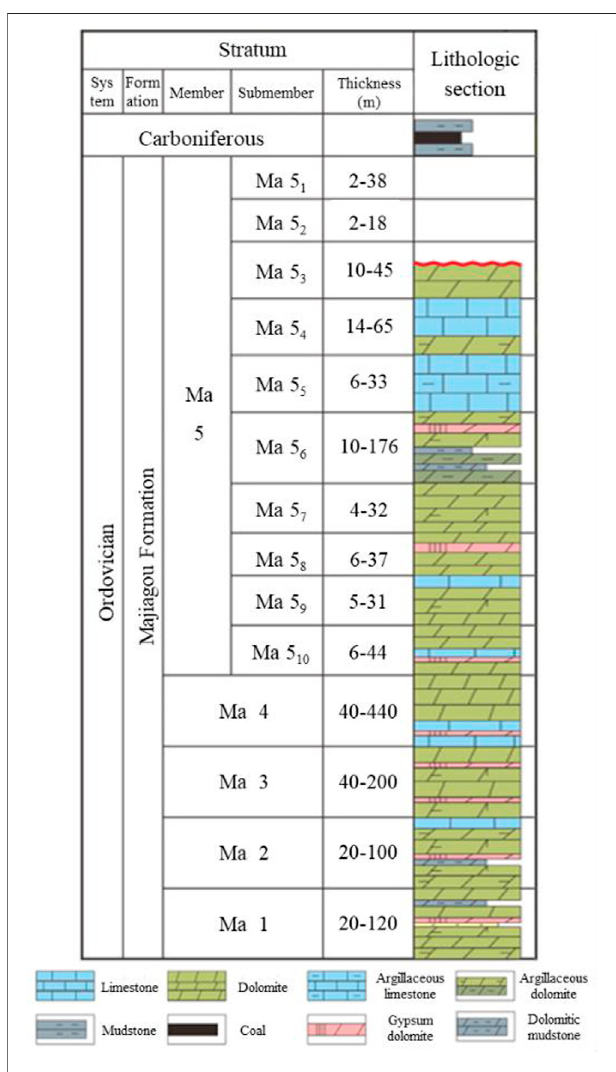
FIGURE 2 | Majiagou Formation lithologic